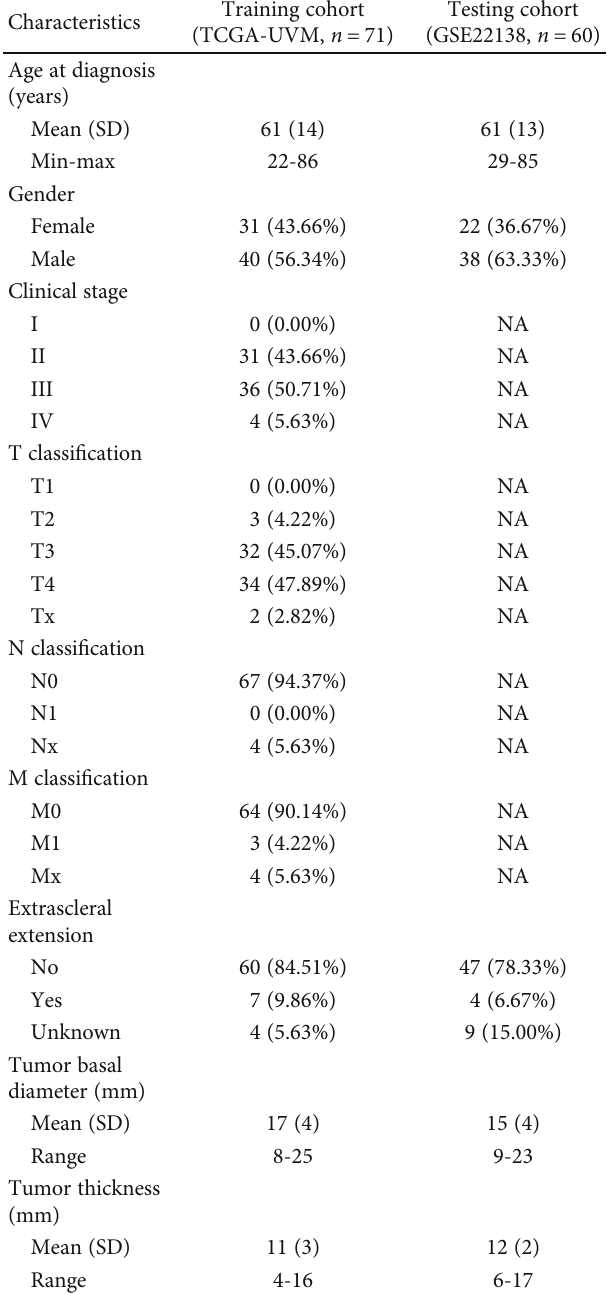
Table 1: Clinical and pathological characteristics of uveal melanoma patients at the time of diagnosis. Missing data is marked as NA (not